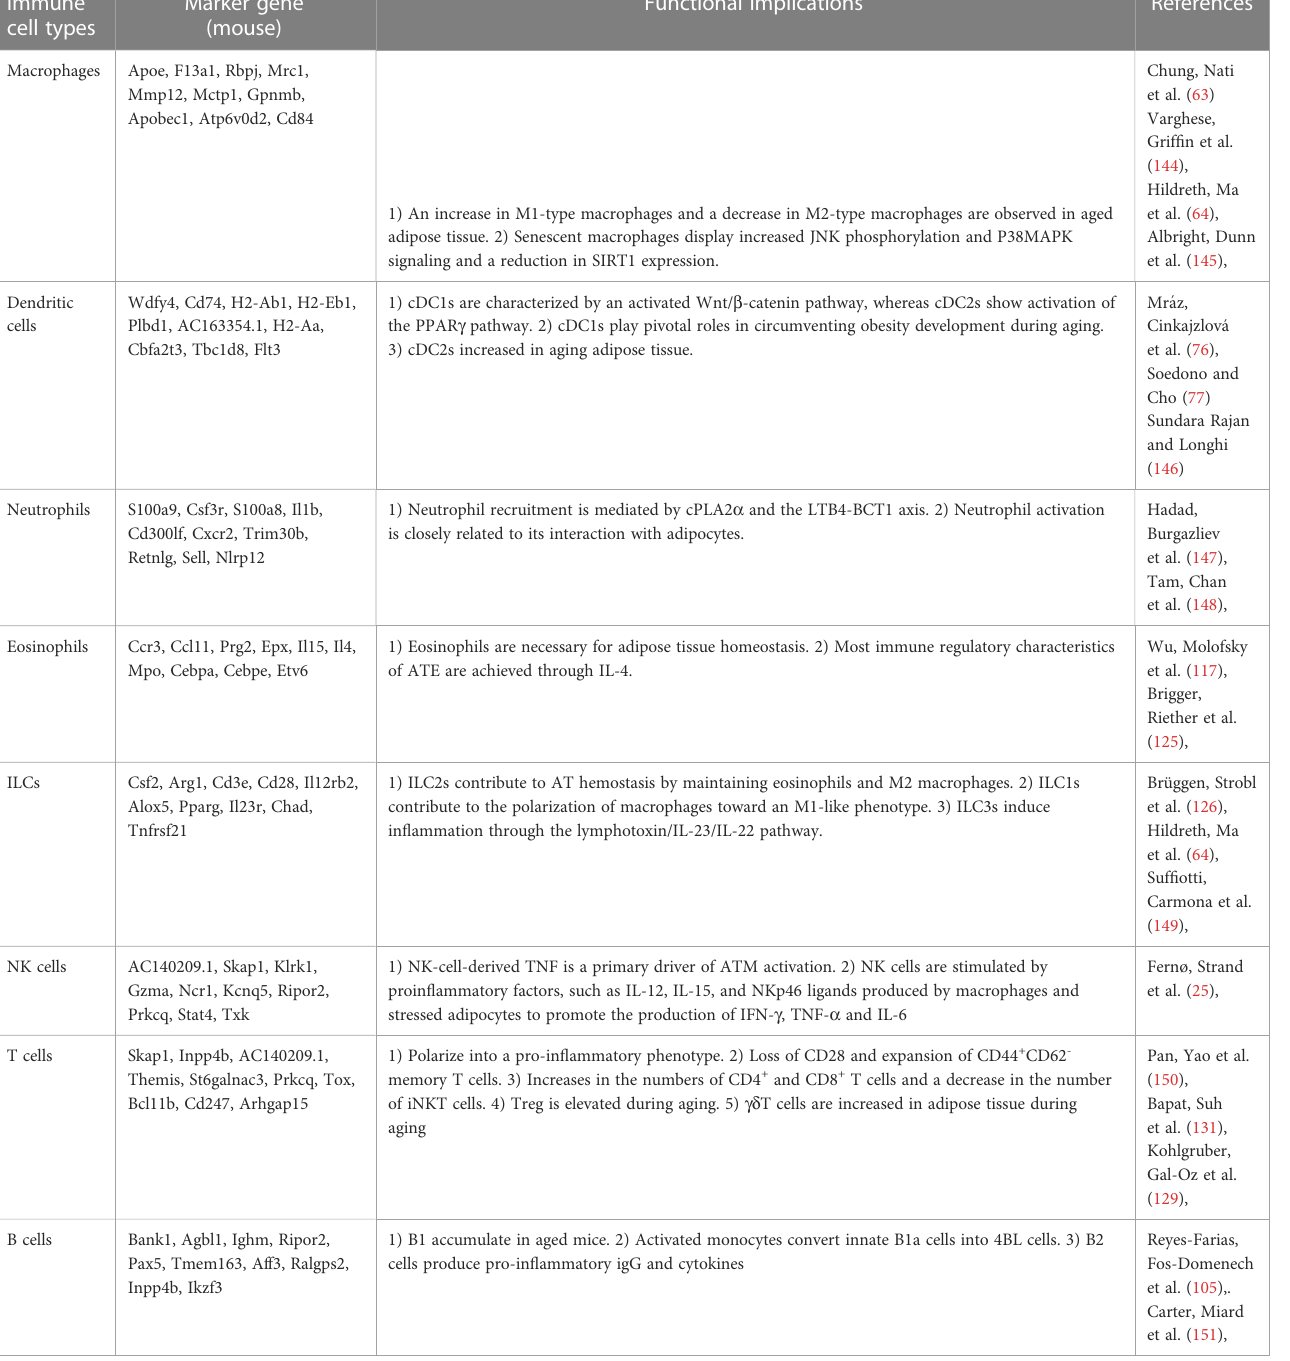
TABLE 1 Immune cells and their functional implications in